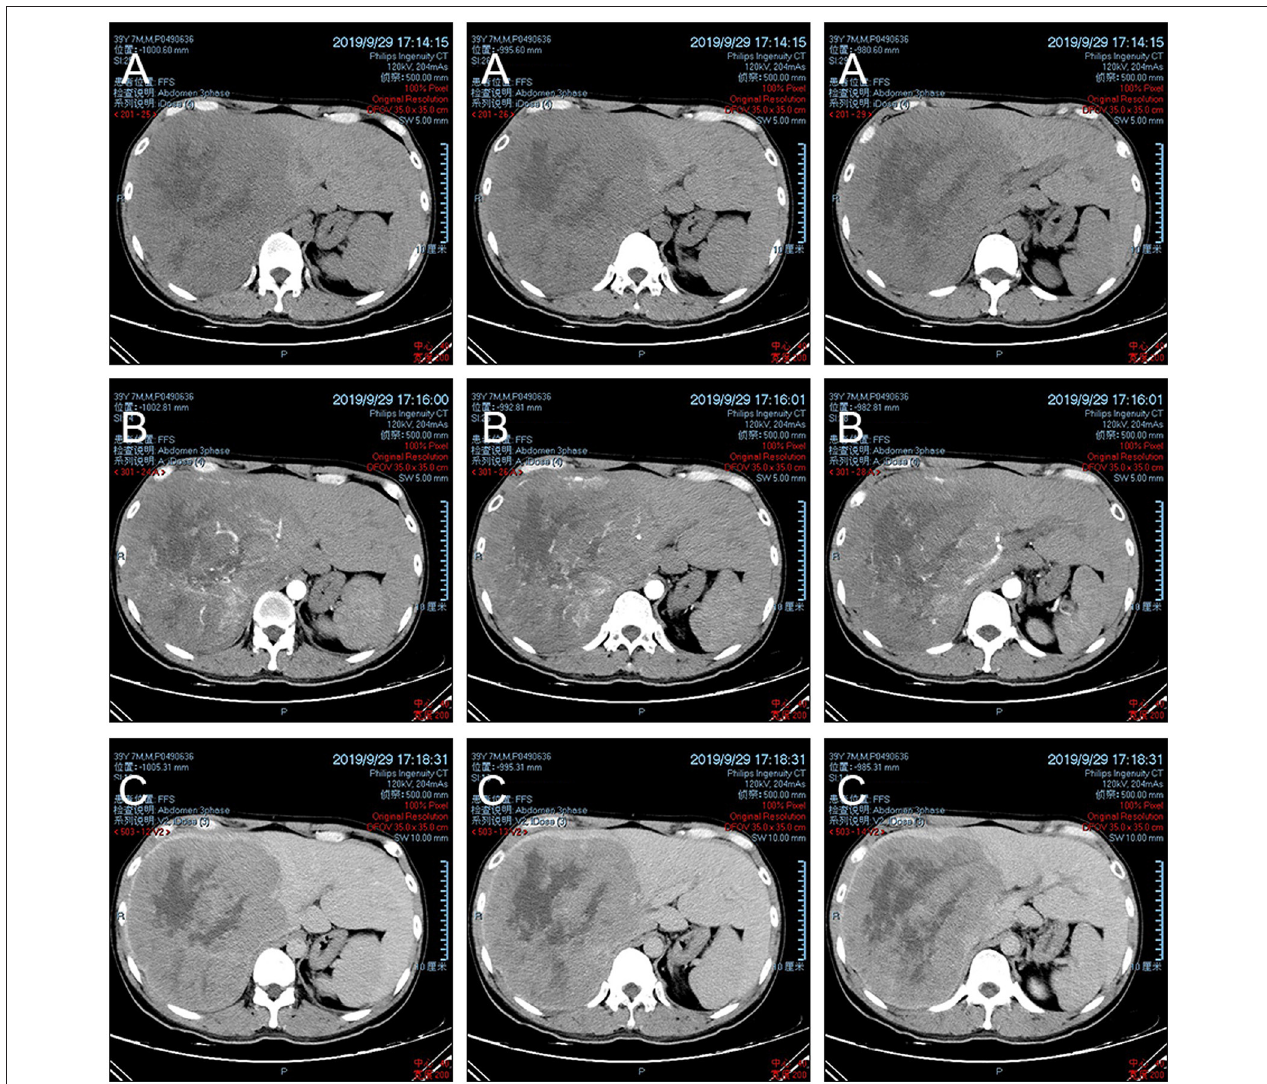
FIGURE 1 | CT images. (A) Plain scan; (B) arterial phase; and (C) portal venous